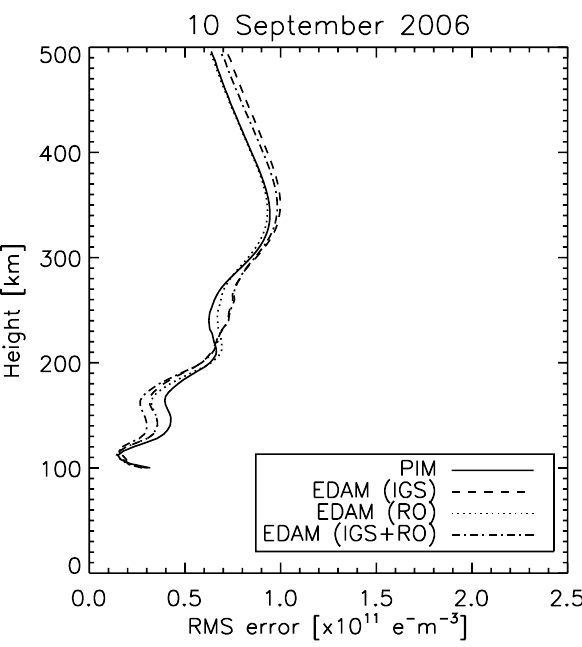
Fig. 5. RMS error between ionospheric models and ionosonde ver- tical profiles at 5km height steps on 4 September 2006 (moderate geomagnetic conditions). The models are: PIM (solid line); EDAM assimilating IGS data only (dashed line); EDAM assimilating COS- MIC RO data only (dotted line); and EDAM assimilating IGS and COSMIC RO data (dot-dash